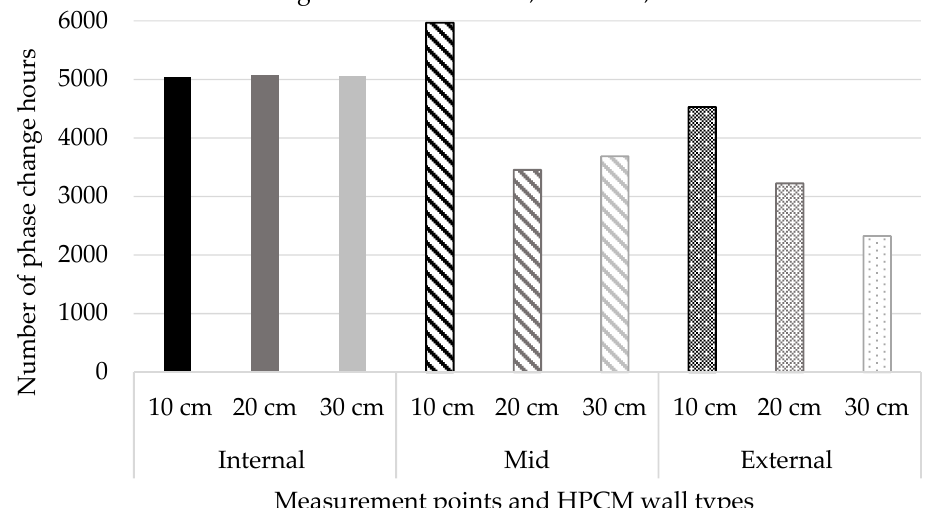
Figure 7. The number of phase change hours of HPCM10, 20, and 30.